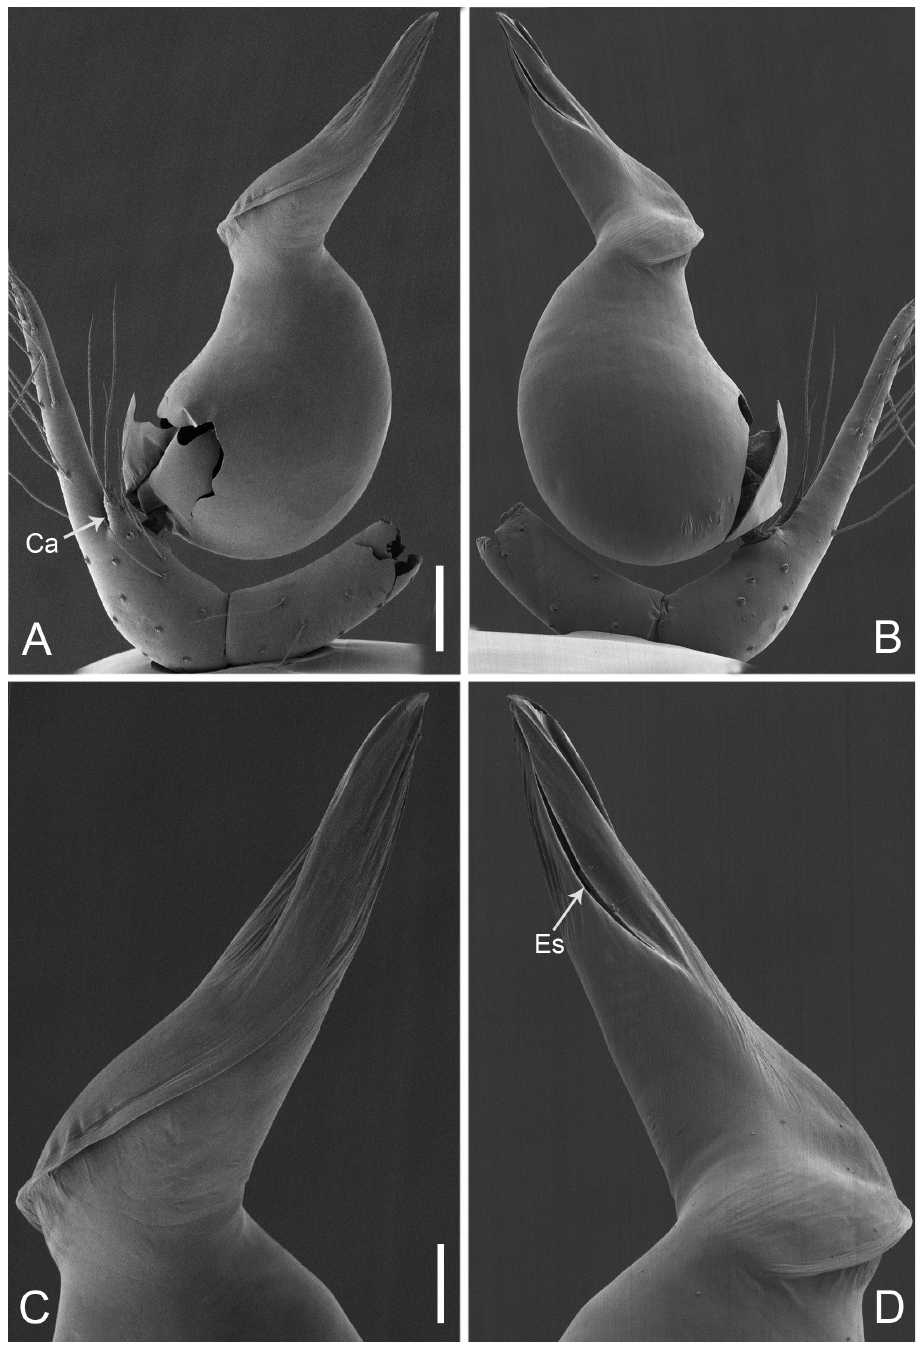
Figure 15. Pinelema strentarsi , male. A Palp, prolateral view B Palp, retrolateral view C Embolus, prolat- eral view D Embolus, retrolateral view. Scale bars: 0.1 mm ( A–B ), 0.05 mm ( C–D